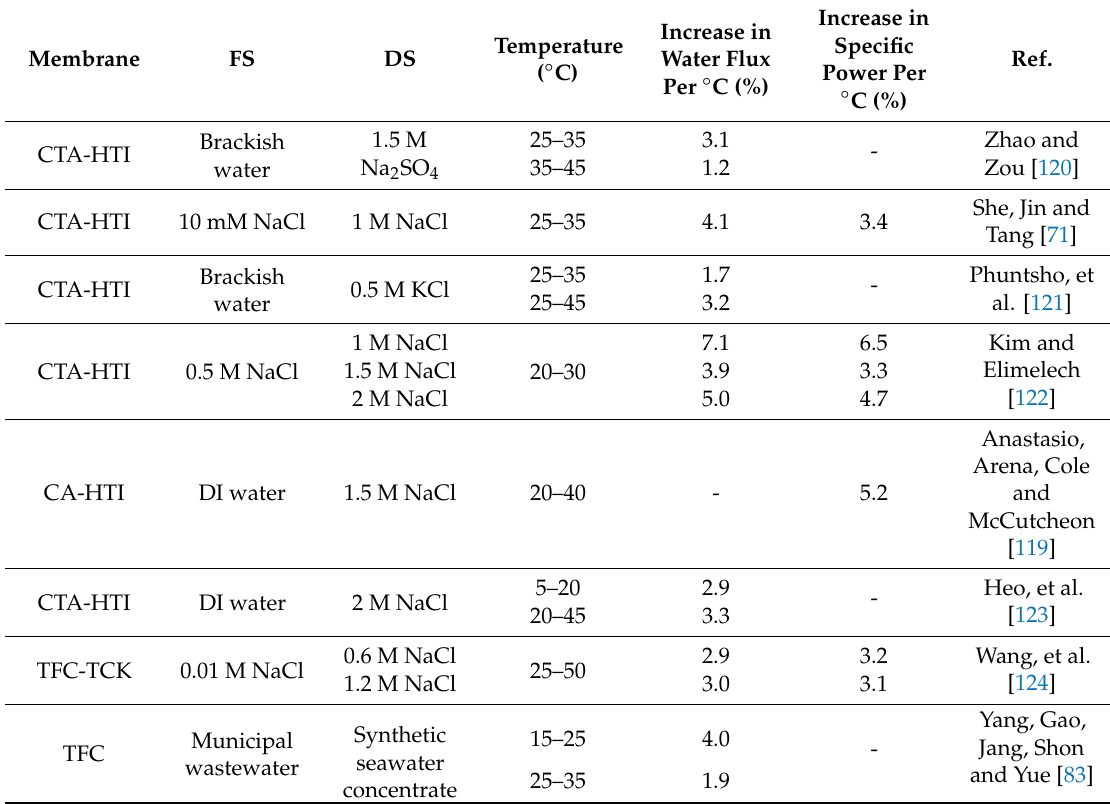
Table 5. Increase in water flux and / or specific power due to increase in